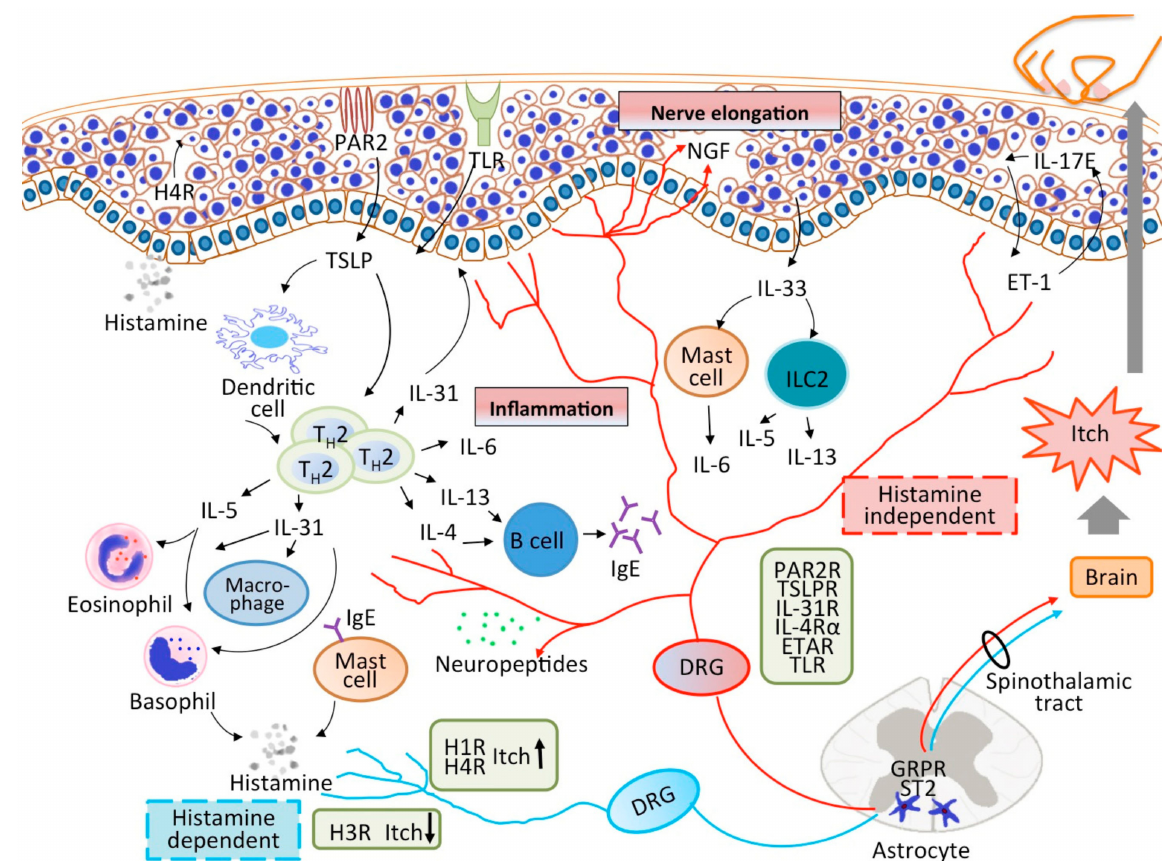
Figure 1. The interplay among the skin barrier, immune system, and nervous system in patients with AD. Skin barrier disruption promotes the release of inflammatory cytokines from keratinocytes, leading to immune activation, particularly of the Th2 pathway. Th2 cytokines initiate the inflammatory process by recruiting and activating more immune cells to the dermis. Simultaneously, various pruritogens are released, activating the cutaneous nerve fiber terminals. The itch sensation can be transmitted by histamine-dependent or histamine-independent pathways. Neuropeptides are released by efferent fibers and stimulate the immune cells to exacerbate the inflammatory process. Moreover, scratching triggered by an itch may further damage the skin barrier, leading to a vicious